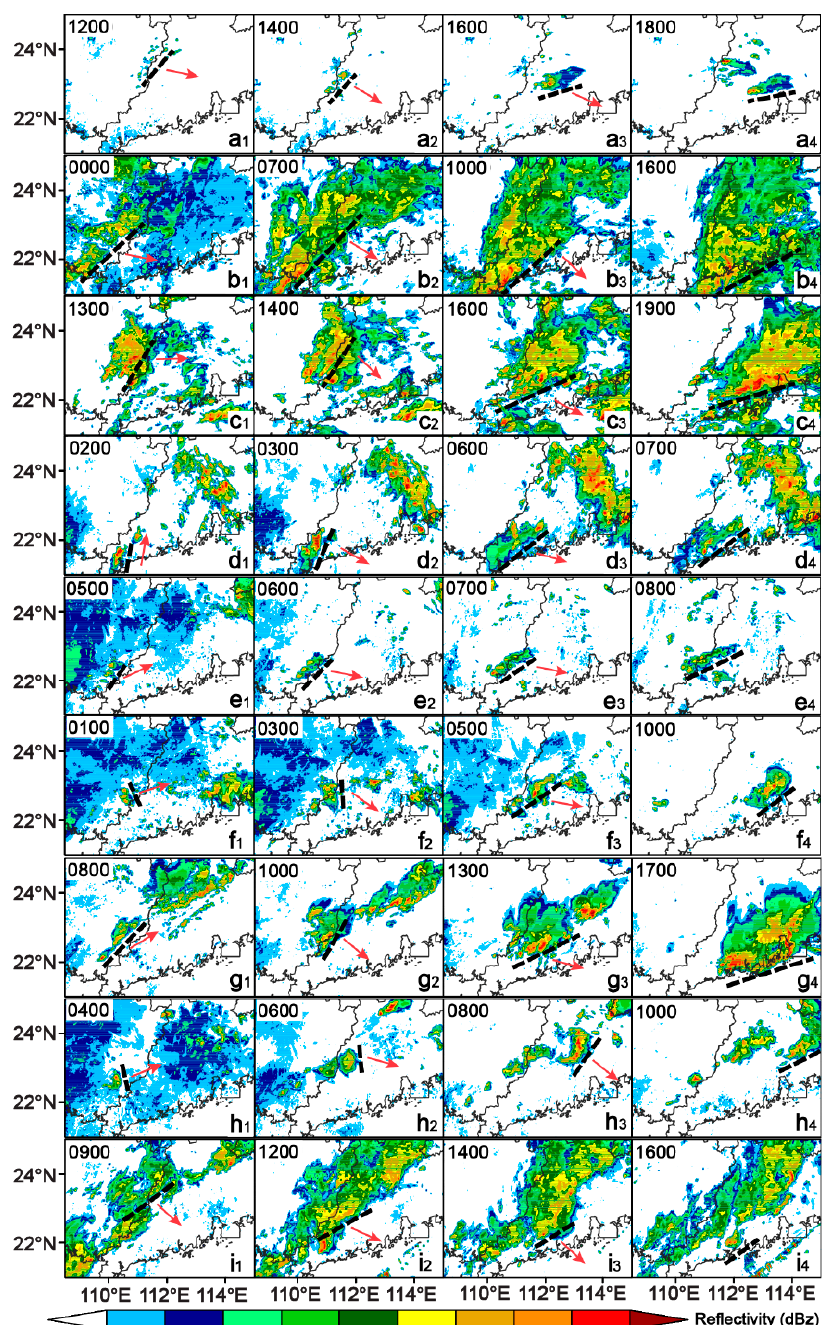
Figure 2. Evolution of composite mosaic radar reflectivity (color-shaded; units: dBZ) over South China for cases 1 to 9 ( a – i ). The occurrence times of the cases are shown in Table 1, and the times labeled in the bottom-right corner of each panel are Beijing Times (BTs). The dashed lines indicate the locations and orientations of the mesoscale convective systems (MCSs), and the arrows indicate their motion directions.